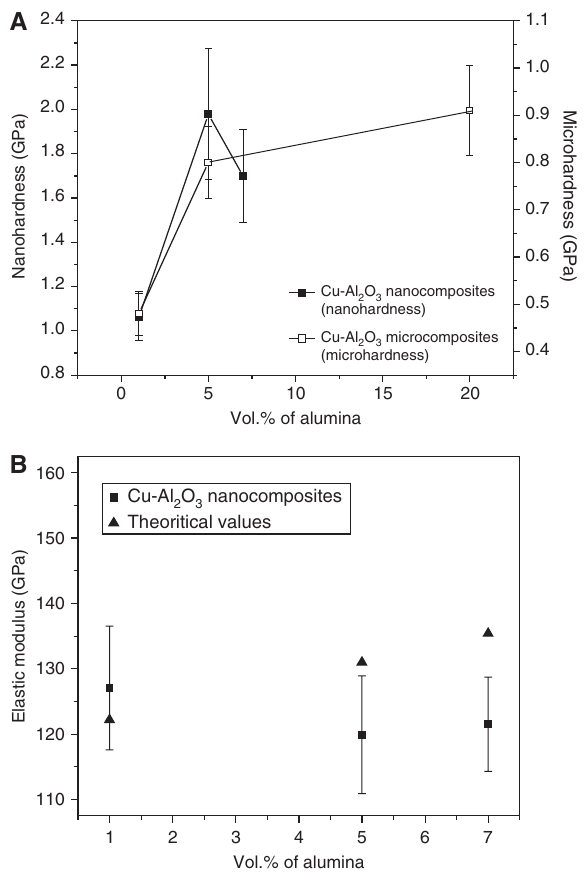
Figure 4: (A) Plot for nanohardness of Cu-Al and microhardness of Cu-Al modulus of Cu-Al